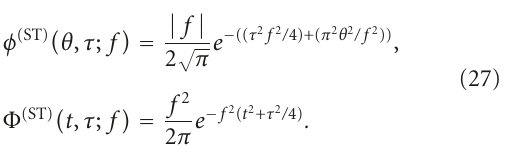
resolution. The corresponding kernel function and the